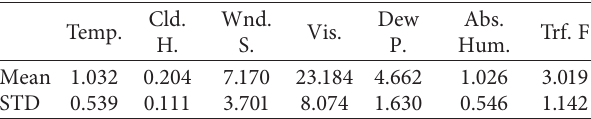
Table 3: Standard regression coefficients and standard regression rank coefficients for the